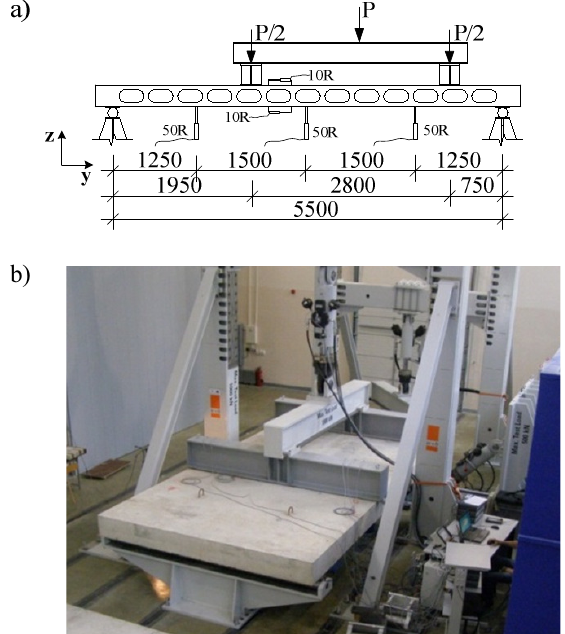
Fig. 3. Slab testing: a) testing scheme; b) testing view